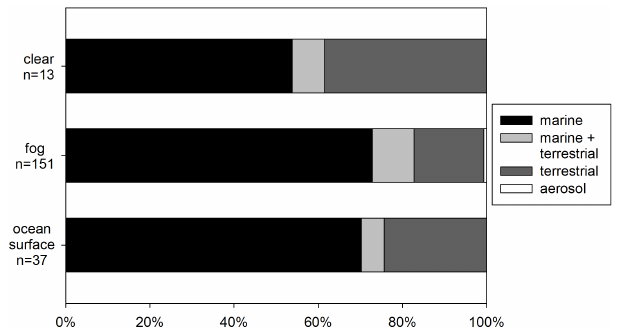
Table 4. Results of similarity indices calculations comparing